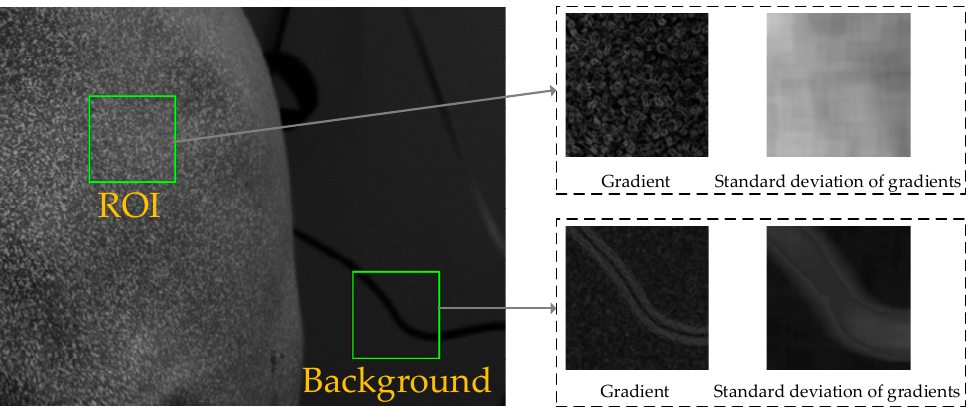
Figure 2. Schematic diagram of background segmentation.